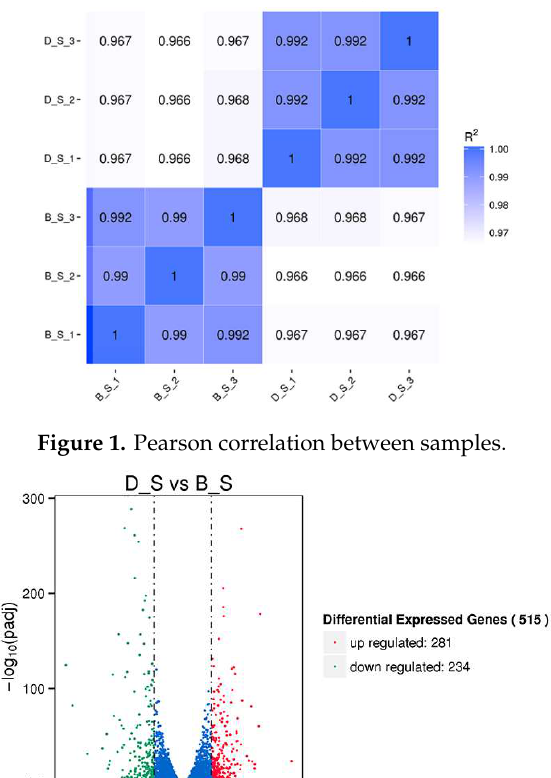
Figure 1. Pearson correlation between samples.